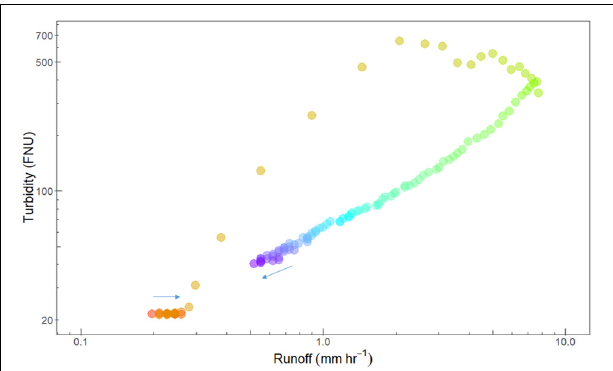
FIGURE 6 | The relationship between turbidity and runoff after a major rewetting event in Rio Icacos (September 2015) showing a clockwise hysteresis loop. Red/orange colors represent the beginning of the storm and blue/purple colors represent the end of the storm. Arrows also provide beginning and ending points of the storm event. Note that both axes are log-scaled. Figure redrawn from USGS sensor data available from Clark et al. (2017). When these data are normalized to peak flow the resultant mean HI value for the event is 0.098. HI values closer to zero indicate less pronounced differences in turbidity between the rising and falling limb of the hydrograph. See discussion text for additional